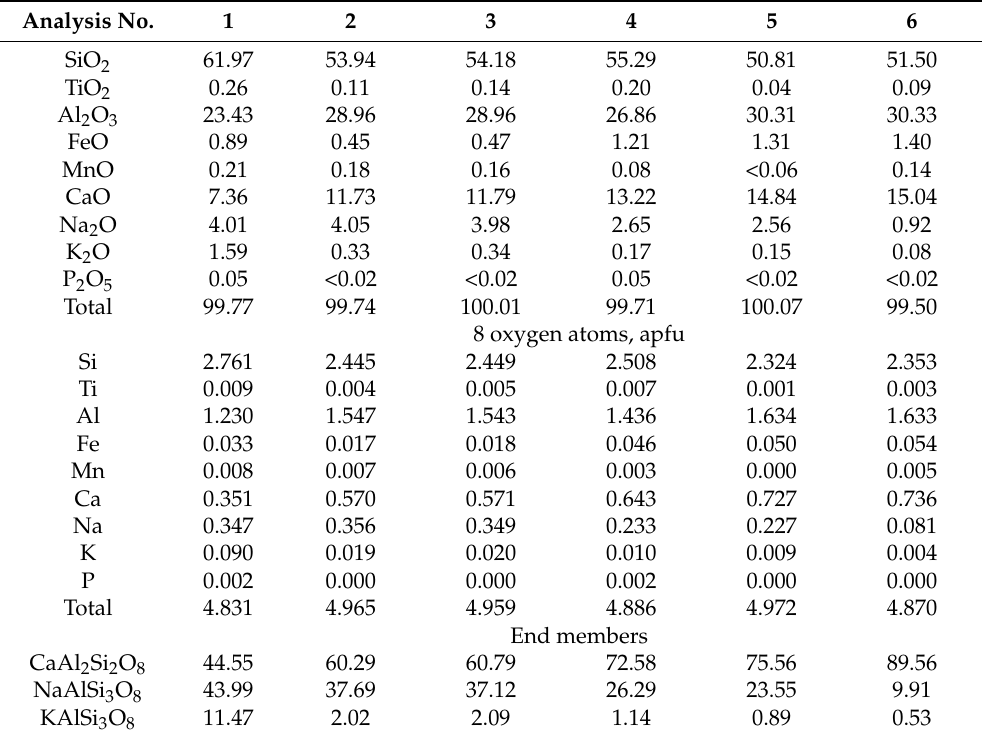
Table 5. Mineral chemistry of plagioclase from combustion metamorphic rocks of Karabetova Gora MV. EPMA data (in